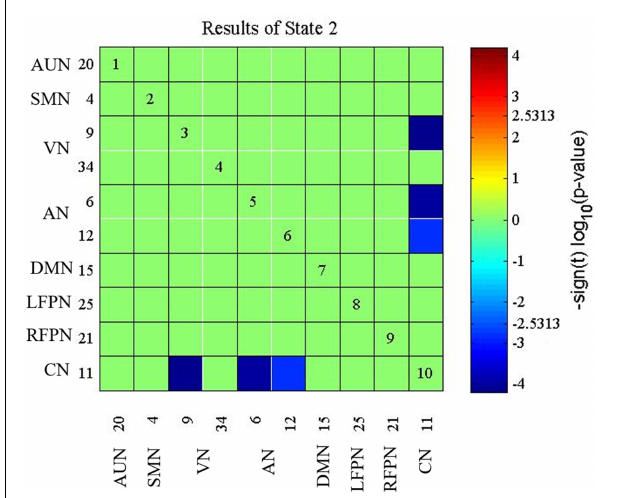
FIGURE 5 | Connectivity results for State 2 evaluated using two-sample t -tests, and the significance was corrected using false discovery rate (FDR): decreased dynamic functional network connectivity (dFNC) in the CN (IC11) with AN (IC6+12) and VN (IC9). CN, cerebellum network; AN, attention network; VN, visual